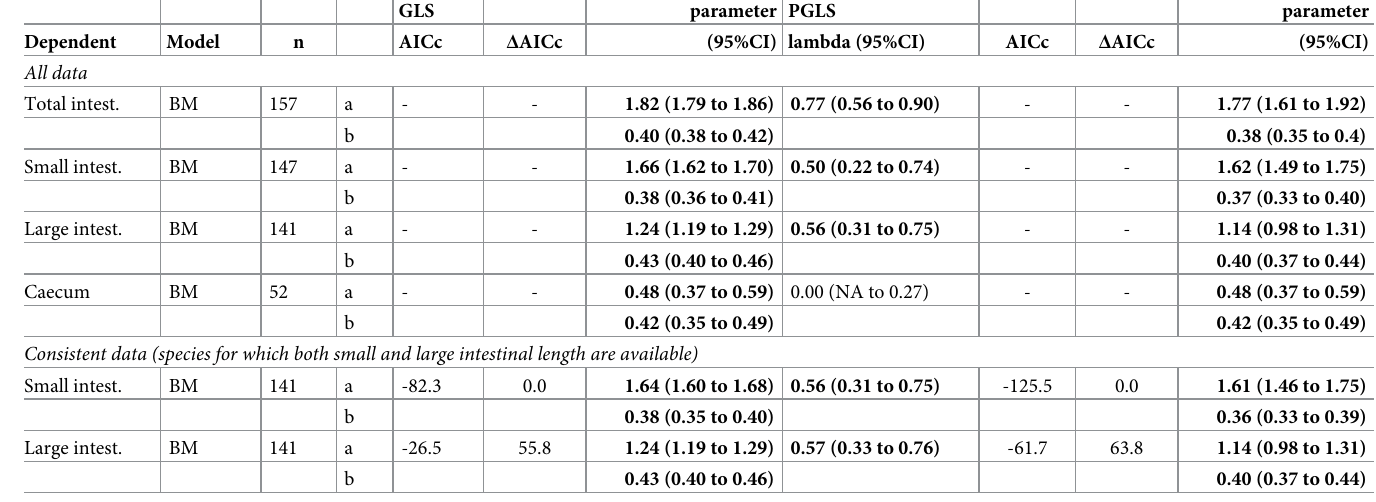
Table 1. Summary statistics for allometric scaling of insteinal length with body mass in reptiles, as log(y) = a + b log(body mass), or y = (10 a ) BM b (significant parameters in